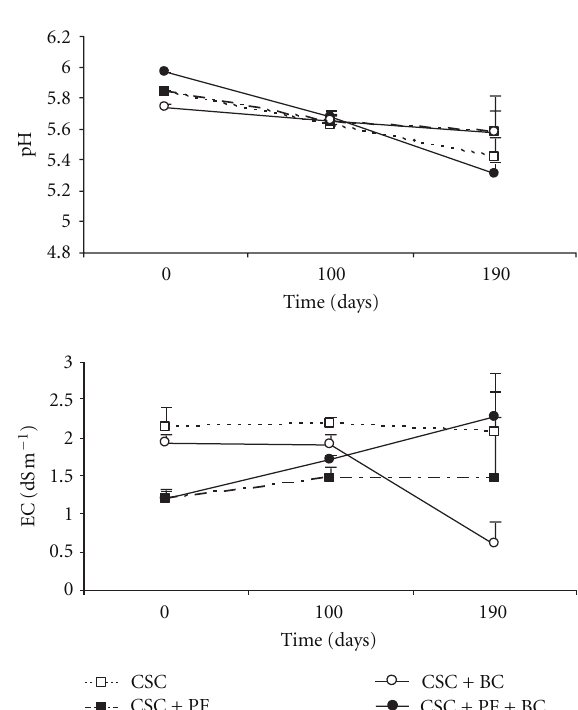
Figure 1: Changes in chemical characteristics of contaminated and organic and inorganic remediated soil, respect to assay time. Treatments: CSC = Contaminated Soil, CSC + PF = Contaminated Soil + Phosphate Fertilizer, CSC + BC = Contaminated Soil + Biosolid Compost, and CSC + PF + BC = Contaminated Soil + Phosphate Fertilizer + Biosolid Compost. The bars indicate Standard Error of the